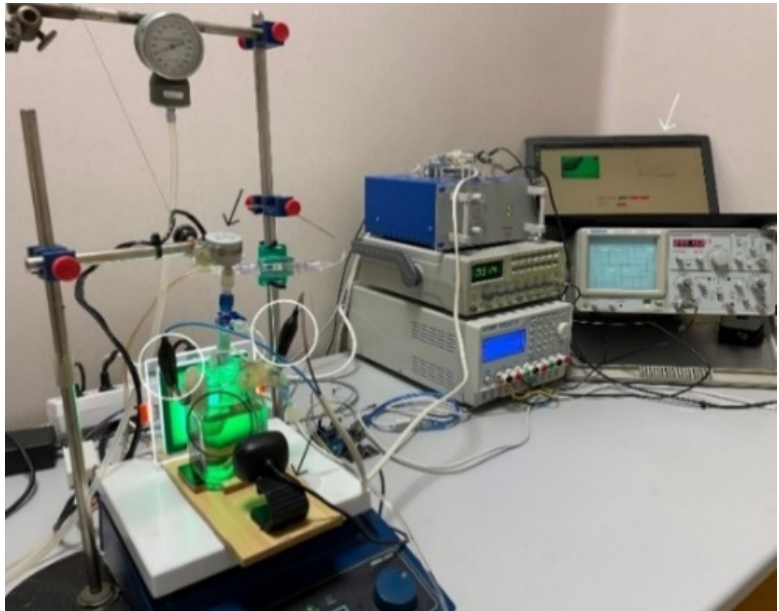
Figure 2. The heart is attached to the Langendorff device using aortic cannulation (black circle). Perfusion is possible with a peristaltic pump, recirculating the 1% SDS solution. A rectangular electric signal is applied to the electrodes from the chamber where the heart is located (white circles). The decellularization process is recorded with a Web camera while a stepper motor moves the heart in the electrochemical cell (black arrows). A deep convolutional neural network (DCNN) model and application were developed to determine the state of the heart during decellularization. The record session view of the application can be seen on the laptop (white arrow).